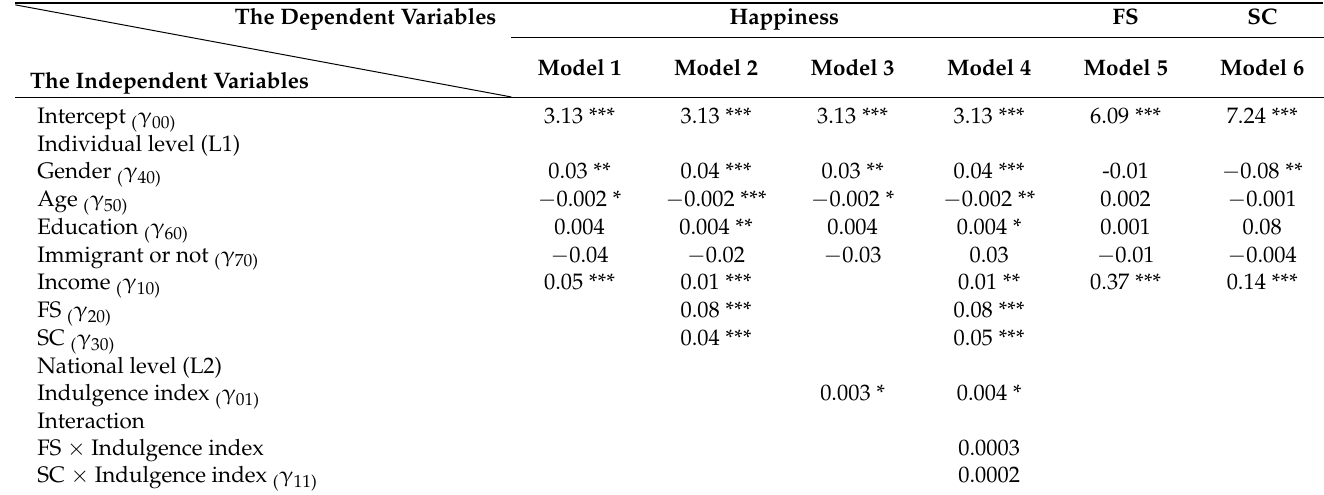
Table 3. Testing the moderated mediation effects for Happiness in study 1 ( N = 49,097).